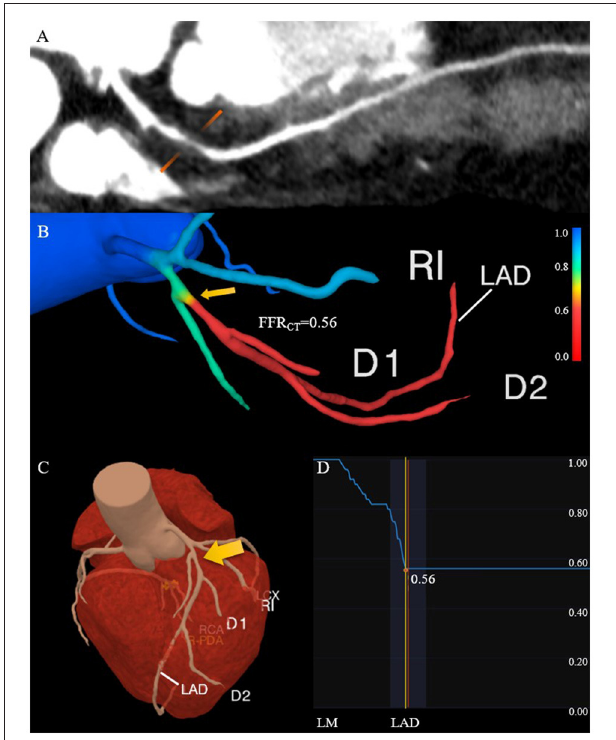
FIGURE 3 | Comprehensive assessment of the characteristics of high-risk plaque with CCTA. (A) The lesion in the proximal of the left anterior descending coronary artery has positive remodeling and low attenuation. (B) The FFR CT map derived from computational fluid dynamics shows a value of 0.56 distal to the stenosis, which indicates lesion ischemia. The transition from blue to red along the left anterior descending coronary artery indicates the decreasing trend of the FFR CT . (C) The 3D model diagram of the coronary artery, and the yellow arrow indicates the location of the high-risk plaque. (D) The curve of the FFR CT value from the proximal to distal of the left anterior descending branch. CCTA, coronary computed tomography angiography; FFR CT, fractional flow reserve derived from